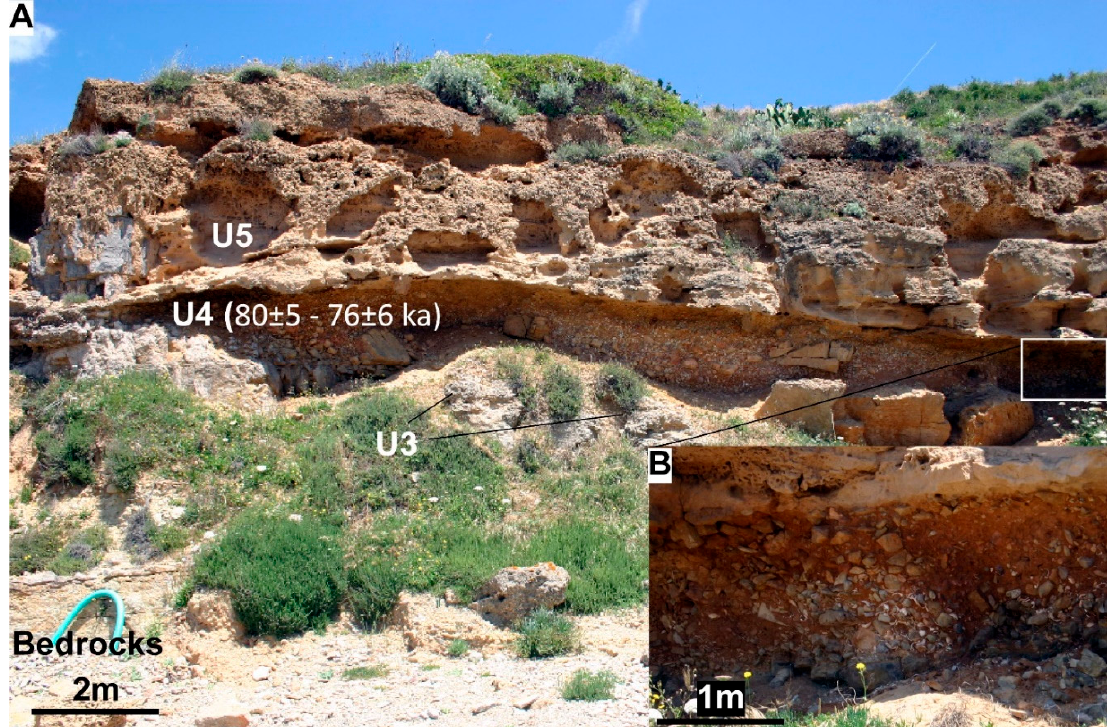
Figure 8. Detail of conglomerate Unit 4 deposits close to the El Trò area. ( A ) They are made of reddish silty, poorly sorted, angular cobbly–pebbly, matrix supported conglomerates. Conglomerates fill channels up to 2 m deep and 7 m wide. ( B ) Glycymeris glycimeris shells. Luminescence ages are made of quartz grains (Optical Stimulating Luminescence (OSL) [33]).